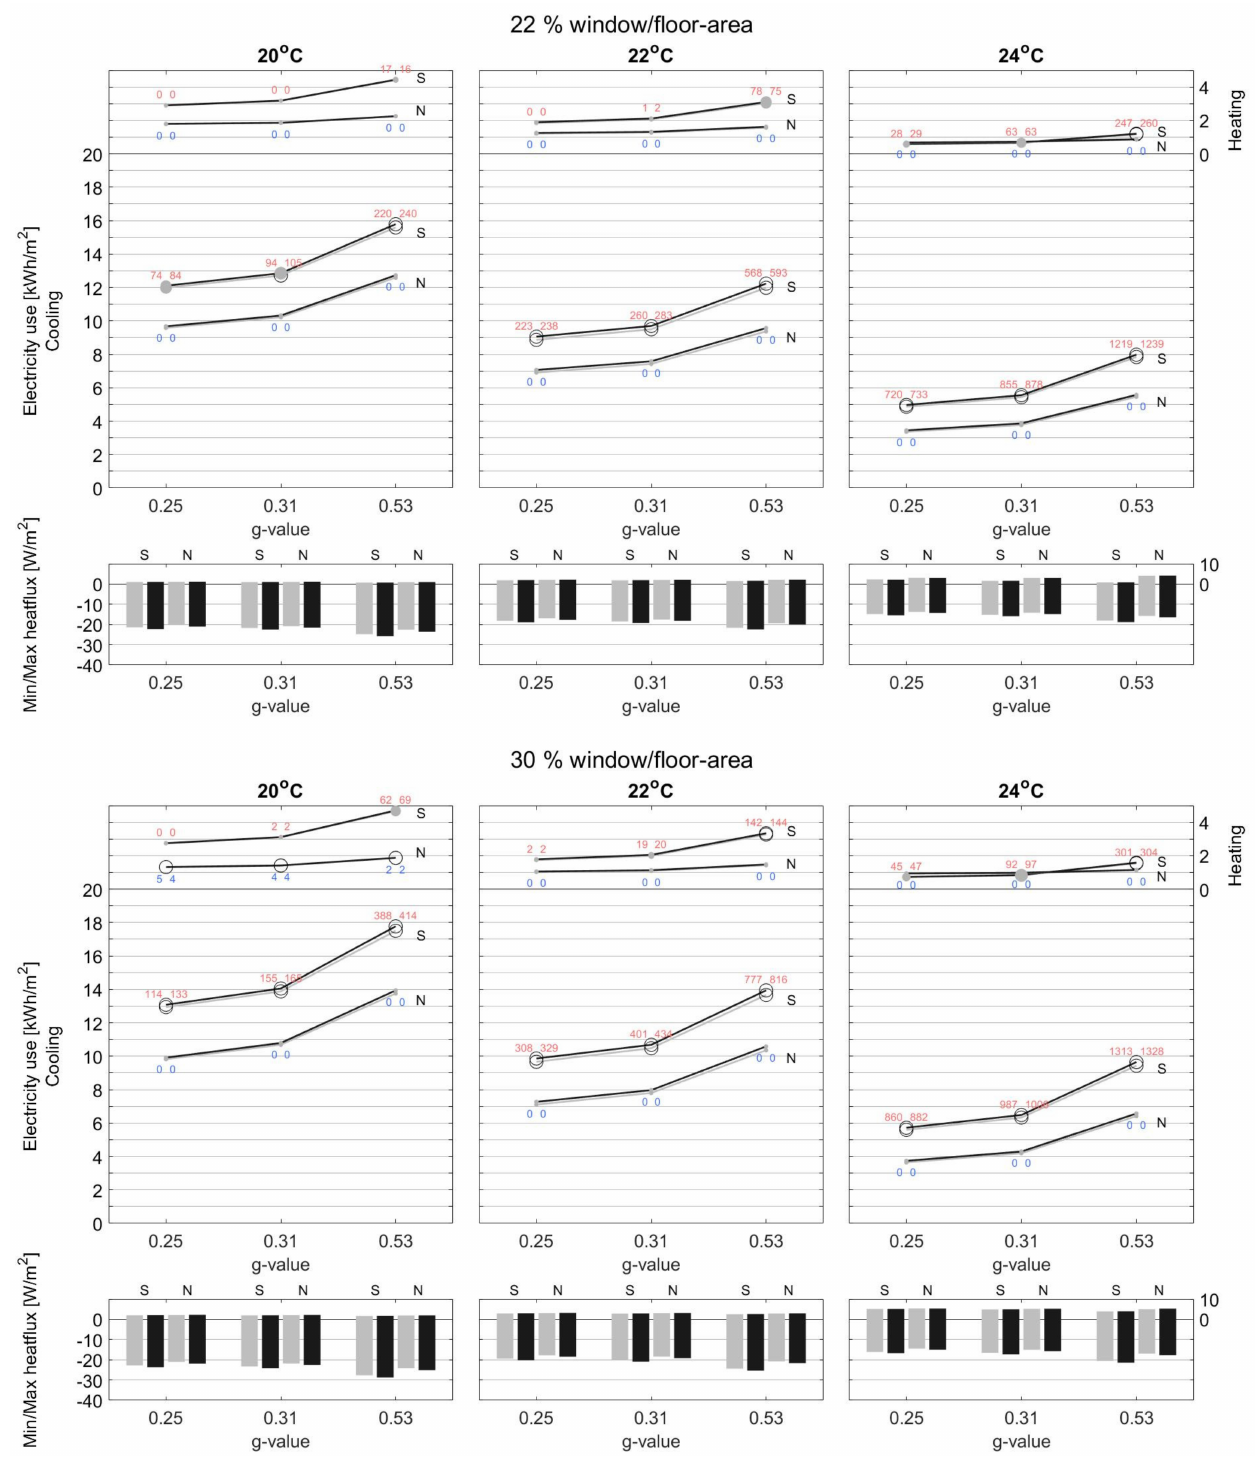
Figure A6. Paris